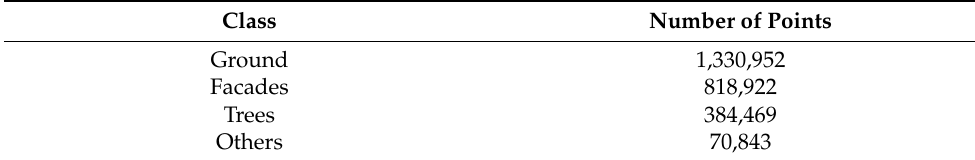
Figure 5. Different views of the labeled LiDAR point cloud of the building. Table 3. Total number of points for each class.